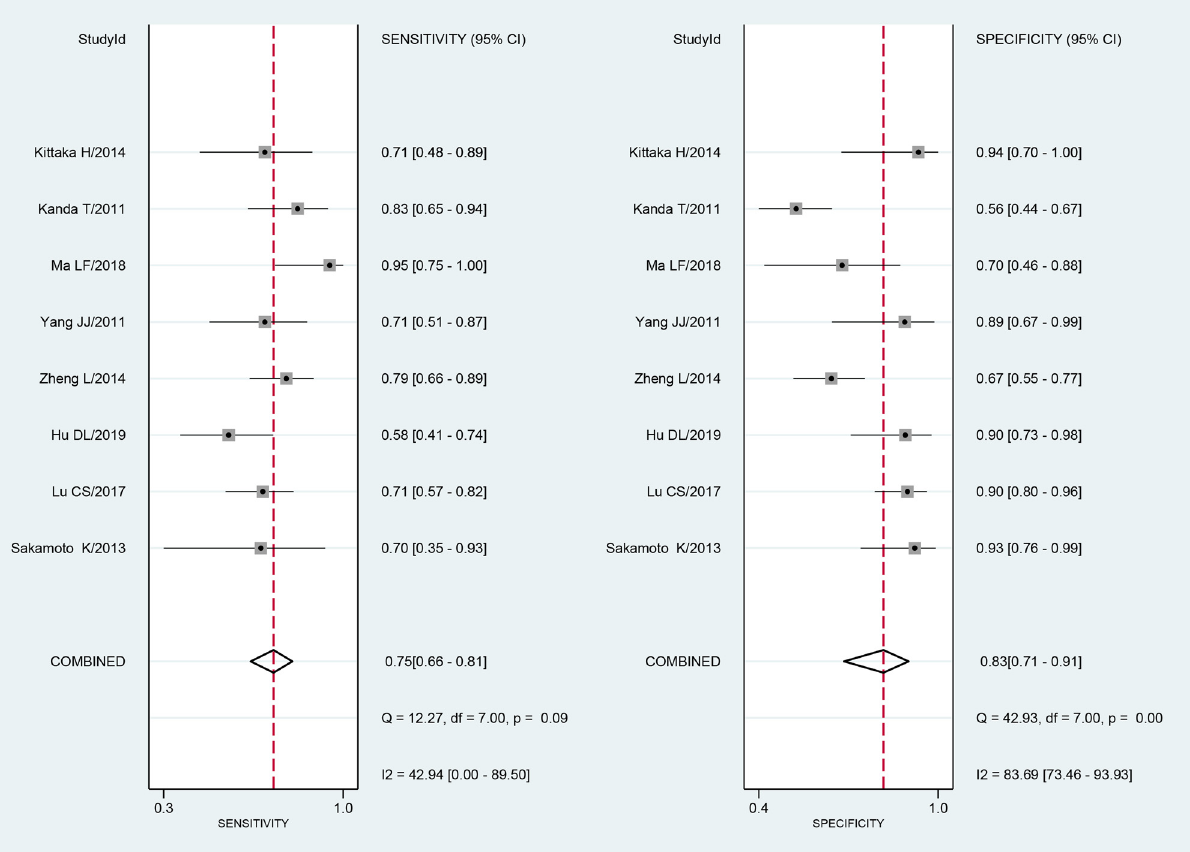
Figure 2: The forest plot of the diagnostic sensitivity and speci fi city for serum I - FABP in diagnosis of strangulated intestinal